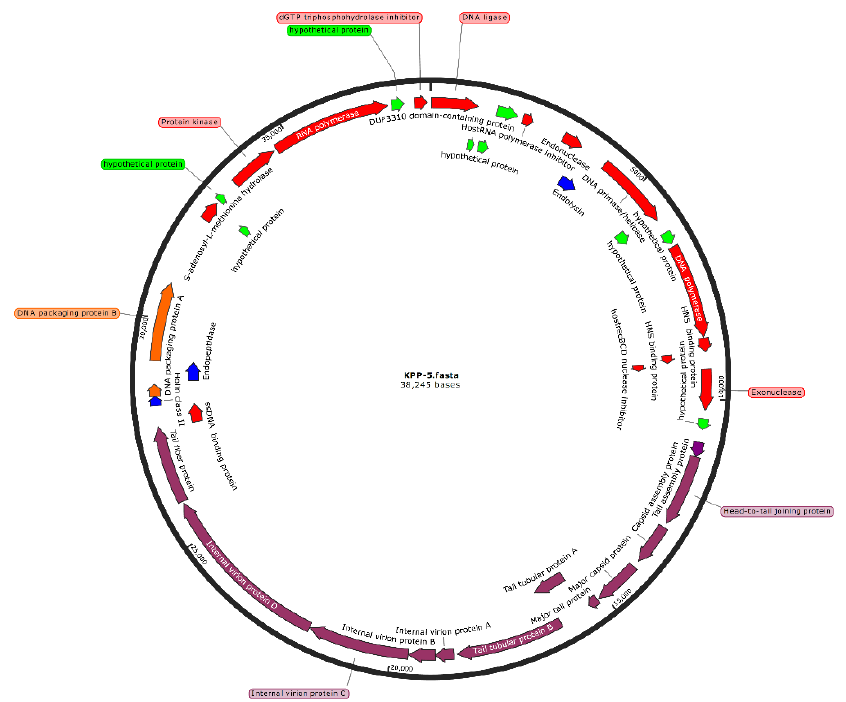
Figure 3. Genome map of Klebsiella phage KPP-5. The open reading frames (ORFs) are indicated by specific colors according to their functional categories. Red: replication, regulation, transcription, and translation-related genes. Blue: host cell lysis-related genes. Purple: phage structure-related genes. Orange: DNA packaging-related genes. Green: hypothetical genes.